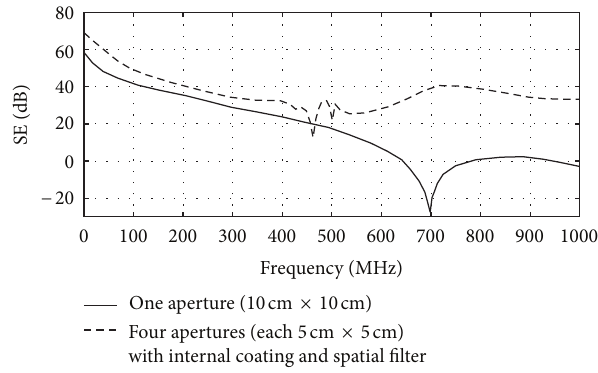
Four apertures (each 5 cm × 5 cm) with internal coating and spatial filter F 21: Shielding effectiveness versus frequency of a 30 internal coating and without a spatial �lter compared to that of an 5 conducting strips, placed 4cm away from the apertures when both are illuminated by a plane wave at normal